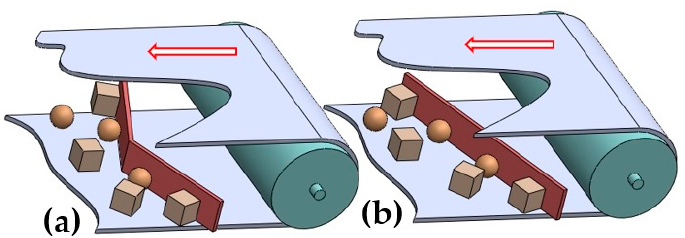
Figure 1. Belt cleaners: ( a ) V-plough, ( b ) diagonal.